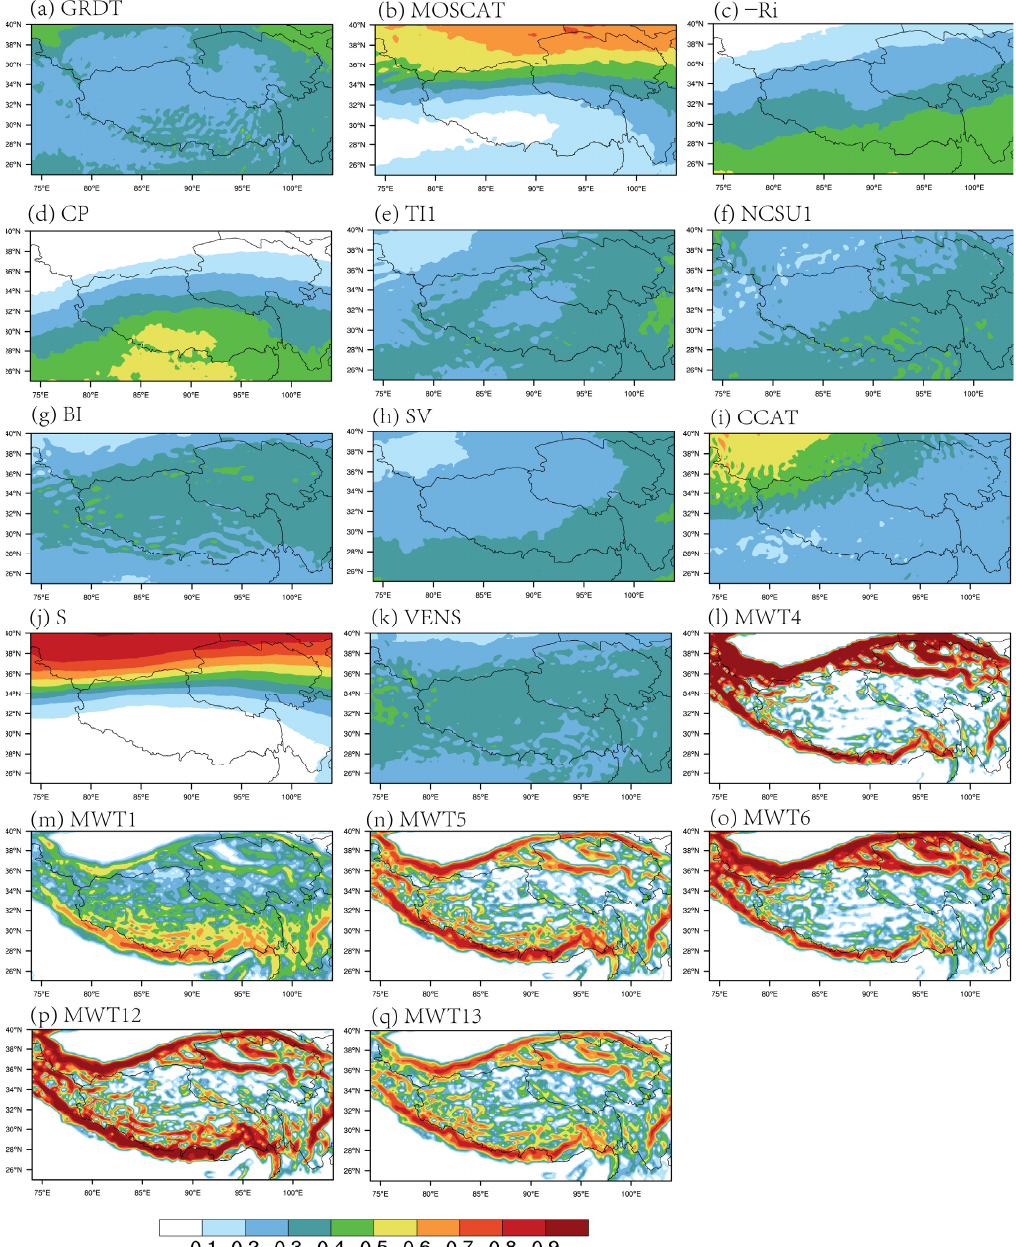
Figure 2. Frequency distribution of 17 turbulence d iagnostics for light or greater turbulence at 200 hPa (2480 epochs in August from 2012 to 2021).